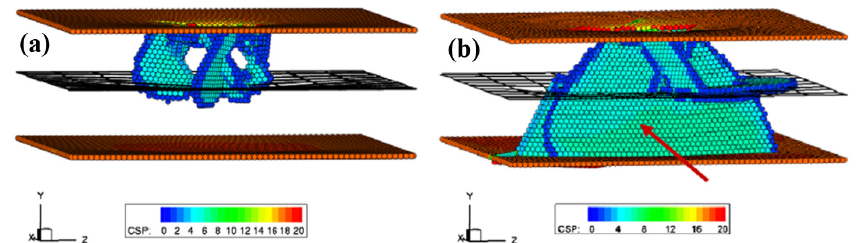
Figure 3. Dislocation structures developing under indention of a Ni-Cu bicrystal. Atoms are color coded according to the centrosymmetry parameter; atoms corresponding to a nearly perfect structure are not shown. Since the interface between Ni and Cu is not visible due to its coherency, a mesh that schematically represents the interface is added to the plots. At an early stage of indentation ( a ), dislocations are contained in the top Ni layer, but have traversed the interface after further indentation ( b ). The arrow points at a stacking-fault plane widening in the Cu bottom layer due to the small stacking-fault energy in Cu. Atoms are colored according to the centrosymmetry parameter. Figure taken from Ref. [46] with